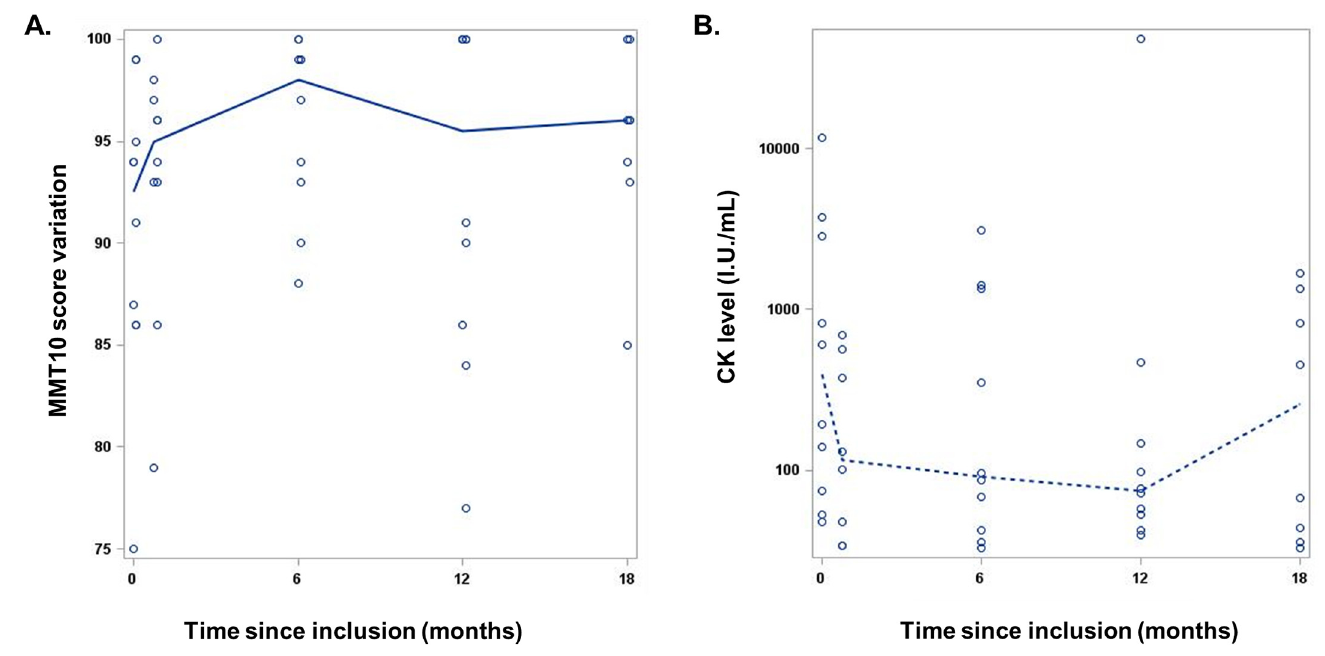
Fig 2. Evolution of strength and CK levels from baseline to months 18. (A) MMT10 using Kendall score. (B) CK level. The continuous line and the dotted line represent the median Kendall score and the median CK level, respectively.